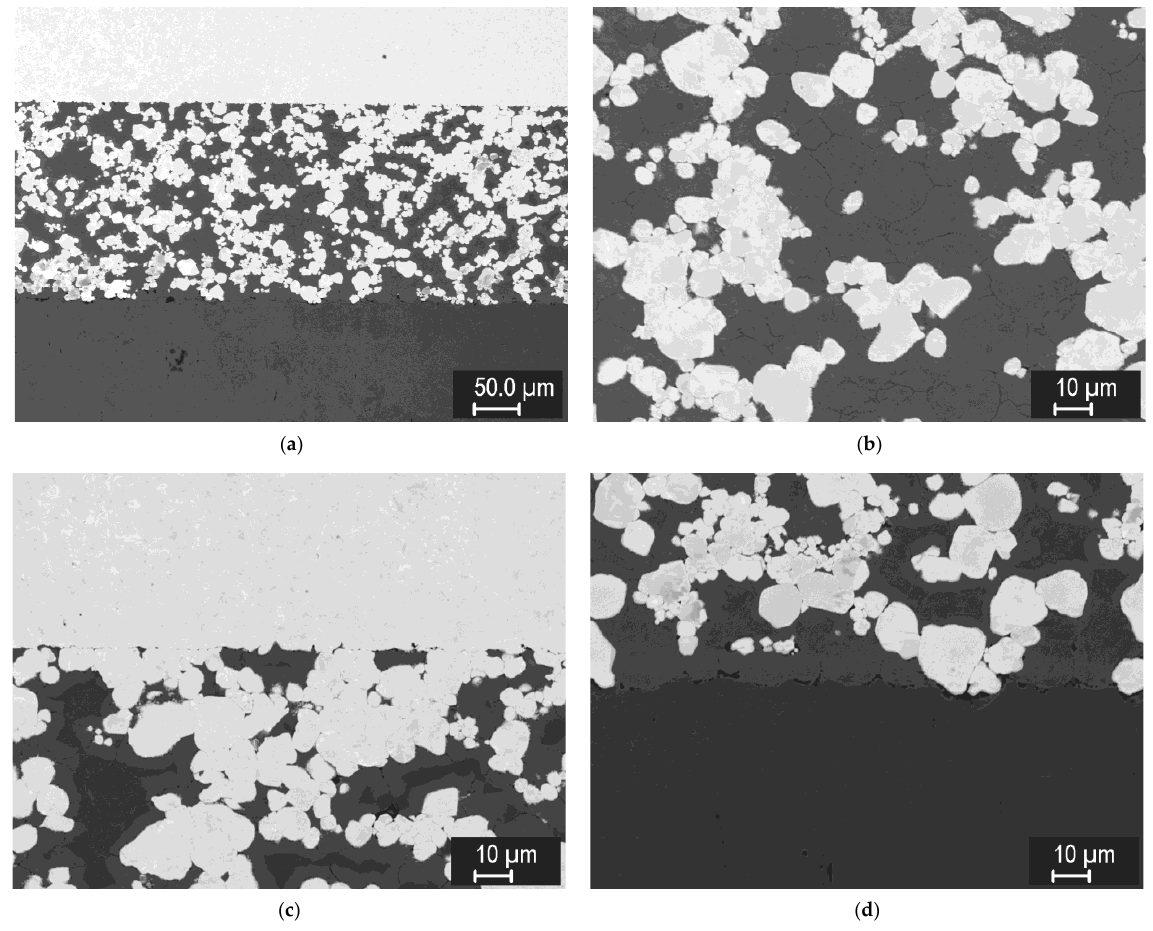
Figure 14. Tungsten-steel joint with a 50/50 mixed interlayer, joined at 1100 °C. ( a ) overview; ( b ) detail of the interlayer; ( c ) detail of the tungsten-composite interface; ( d ) detail of the composite-steel interface.